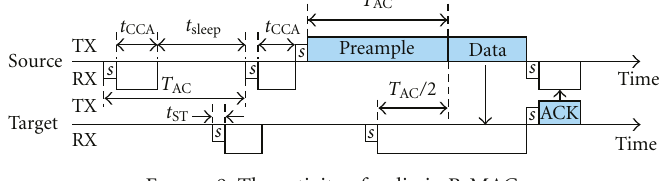
Figure 9: The activity of radio in B-MAC.